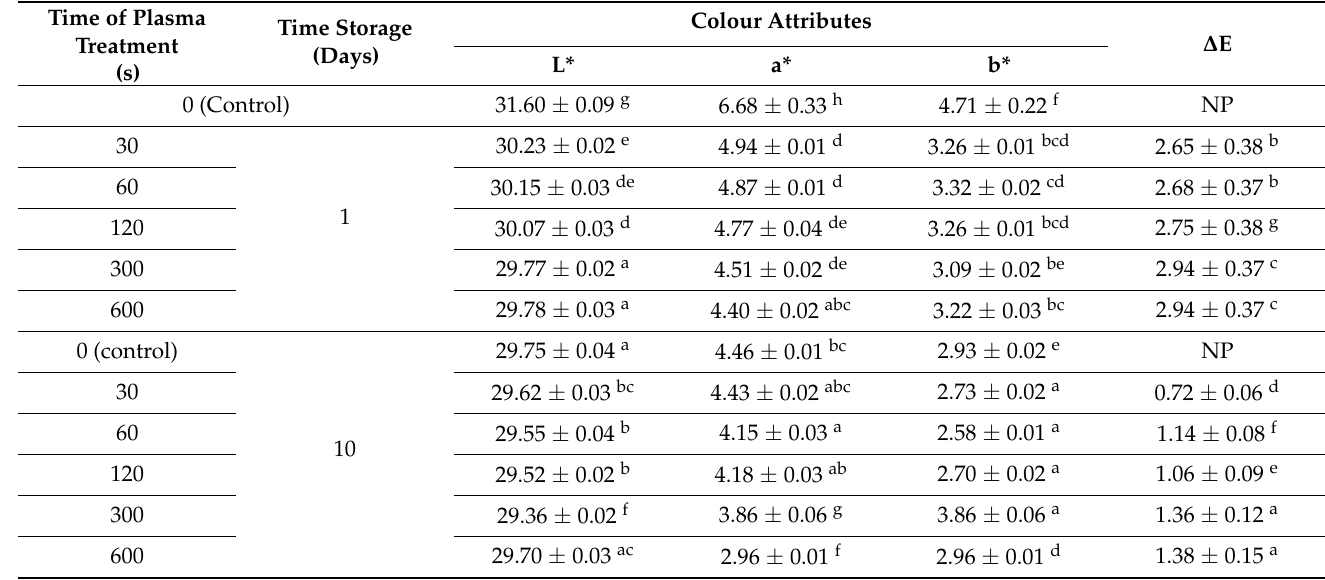
Table 2. Effects of cold plasma processing on color